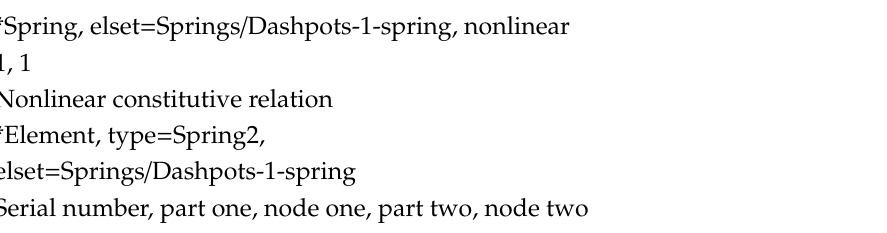
Figure 13. F–D curve for intermediate node spring element of SRRC-1.